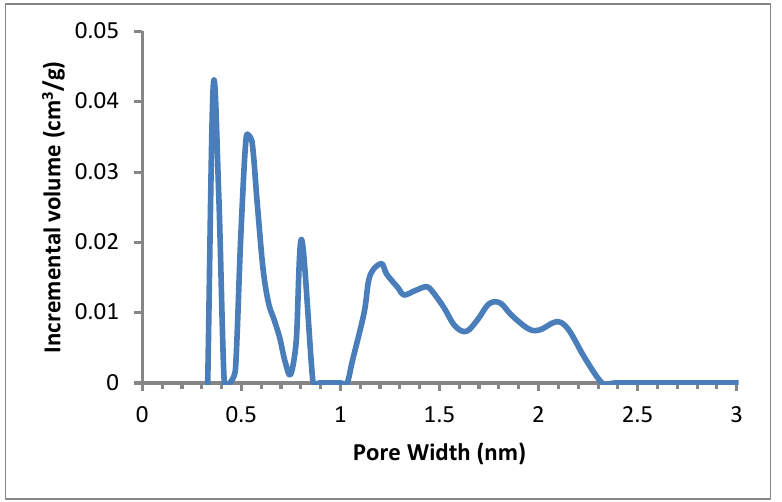
Figure 3. adsorption-desorption isotherms of N 2 at 77 K for the AC.